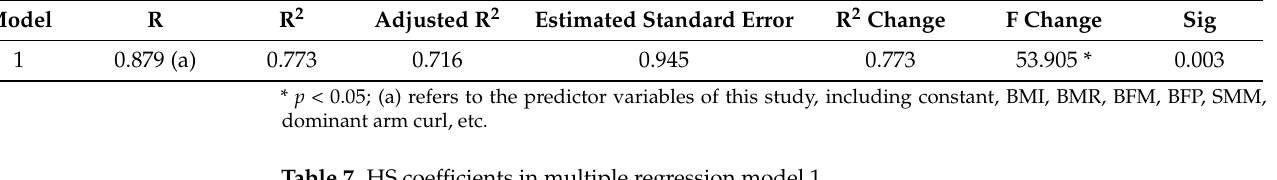
Table 7. HS coefficients in multiple regression model 1.